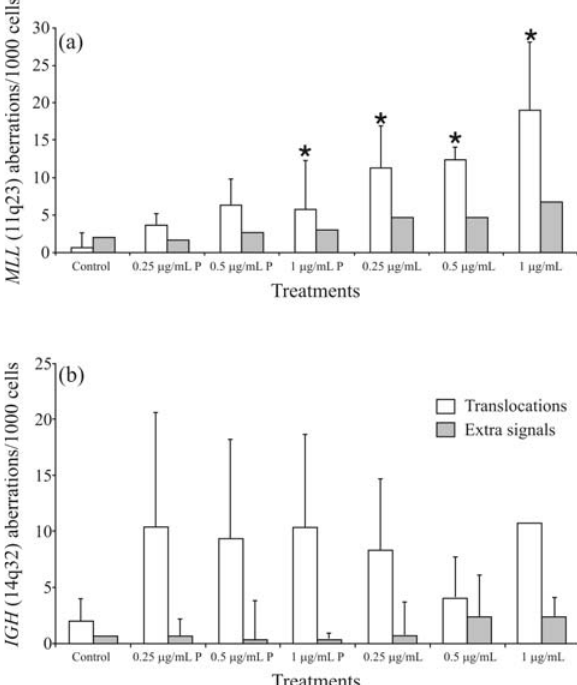
Figure 4 - Mean aberration frequencies of apoptotic (white bars) and ne- crotic (grey bars) cells observed in negative controls and in lymphocyte cultures treated with different etoposide concentrations: A) One-hour- pulse treatment and B) continous 48 h treatment.